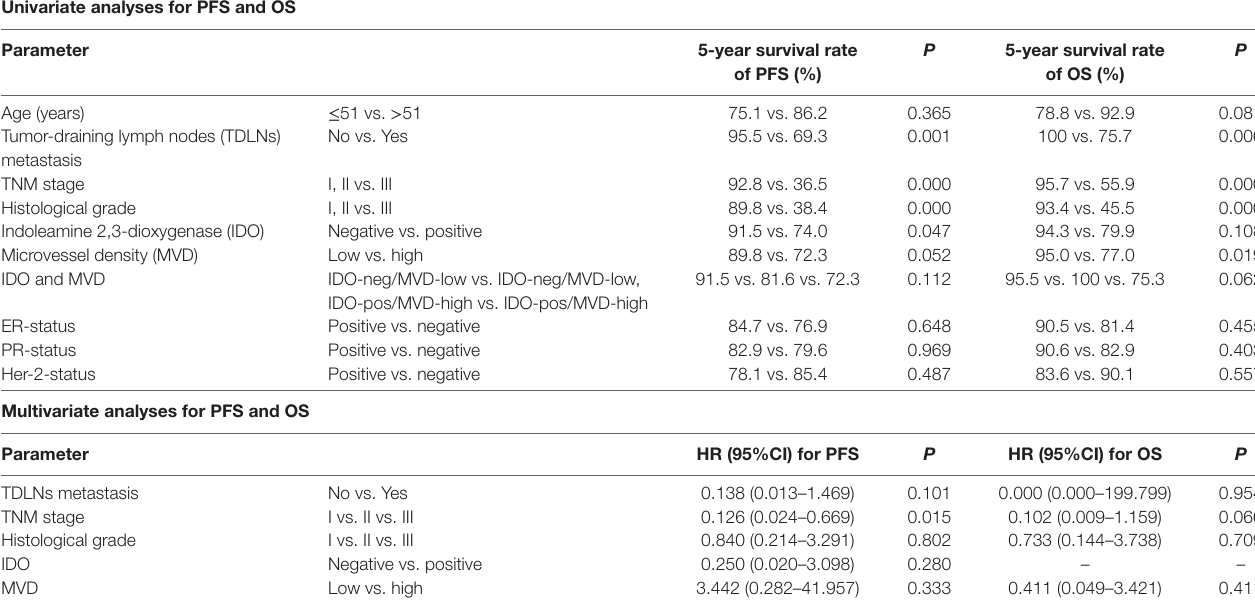
TaBle 3 | Univariate and multivariate analyses for progress-free survival (PFS) and overall survival (OS). Univariate analyses for PFs and Os Parameter